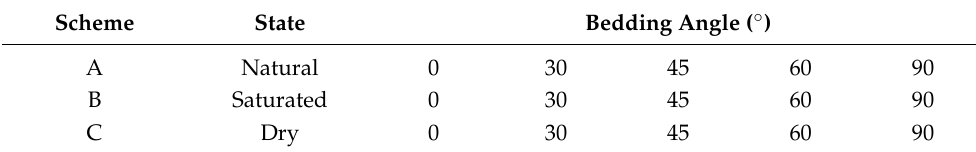
Table 1. Creep experiment scheme.